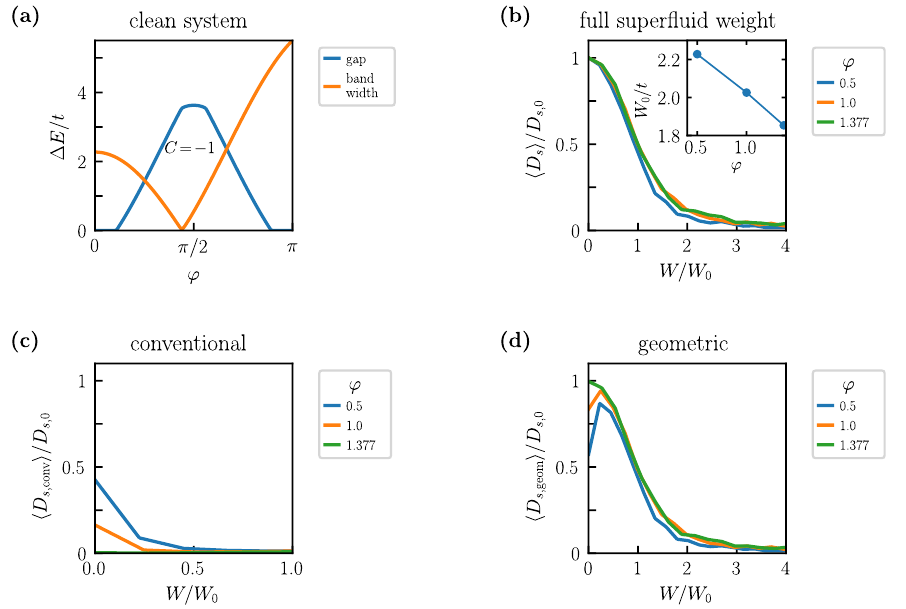
Figure 7: Properties of the extended Kane-Mele model as a function of the NNN / 100, and ¯ ν = 1 / 2: (a) Evolution of the hopping phase ϕ for U = 3 t , T = T c ,0 energy gap and the bandwidth of the lower band. The band has optimal flatness = 1.377. We also indicate the Chern number of the lower spin-up band at ϕ opt where the gap is nonzero. Full superfluid weight (b), conventional contribution (c), and geometric contribution (d) as a function of disorder W for various fixed NNN hopping phases ϕ . The inset in (b) shows the disorder scale W as a function of ϕ 0